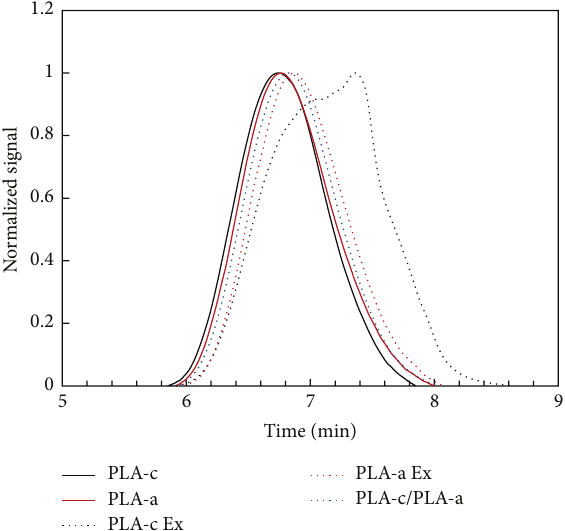
Figure 1: GPC curves of PLA after Haake melt